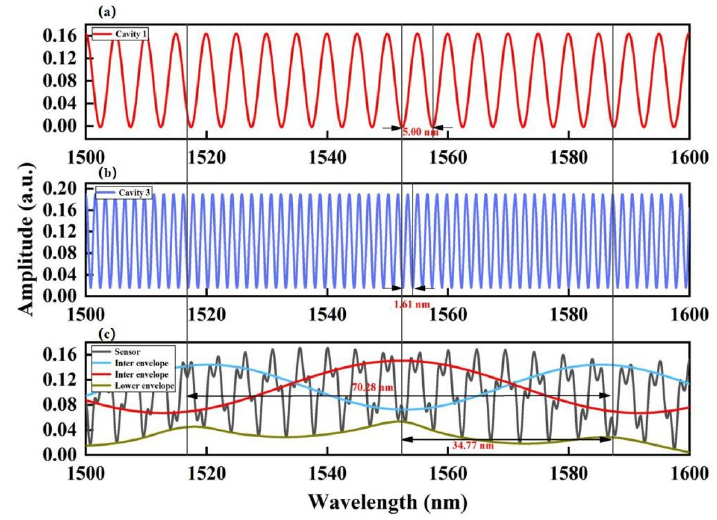
Figure 5. The corresponding interference spectrum for ( a ) Cavity–1 and ( b ) Cavity–3. ( c ) The measured optical spectrum of the sensor at room temperature and standard atmospheric pressure.